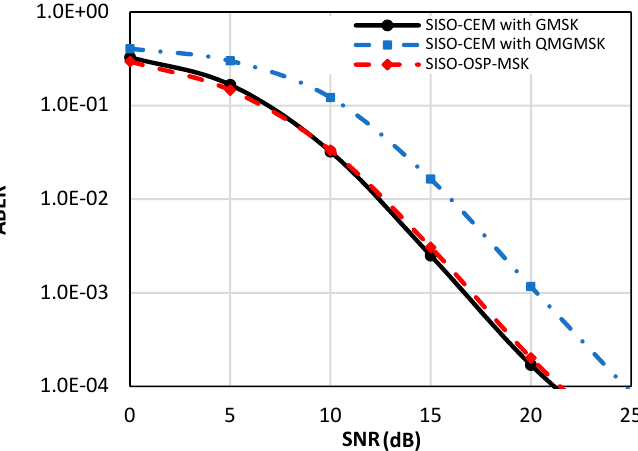
Figure 6. The ABER performance of the proposed single-input single-output orthogonal shaping pulses minimum shift keying (SISO-OSP-MSK) compared to the ABER of the conventional SISO-CEM system with Gaussian minimum shift keying (GMSK) and quadrature multiplexed Gaussian minimum shift keying (QMGMSK) modulation schemes [32,33].